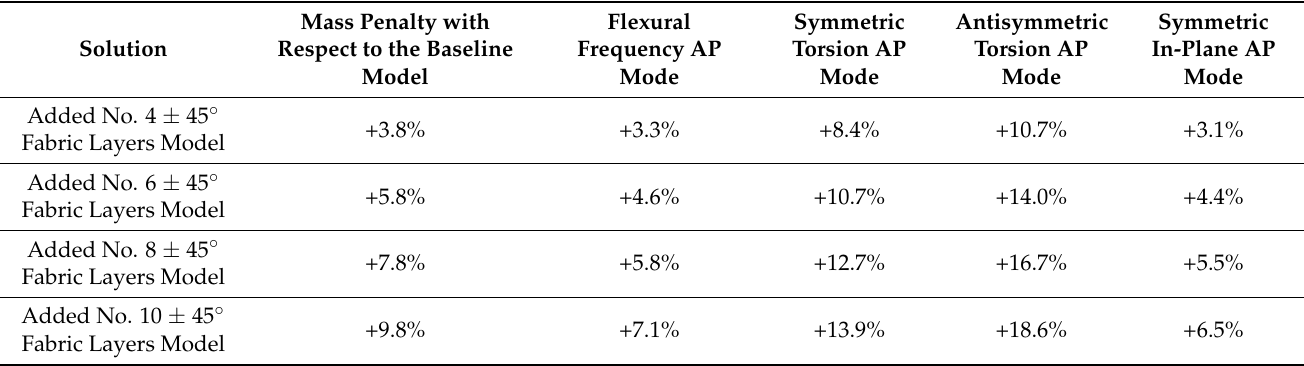
Table 3. Wing Dynamic Status: Aircraft Flexural and Torsional Modes for the added ± 45 ◦ fabric layers models in the AP mode.